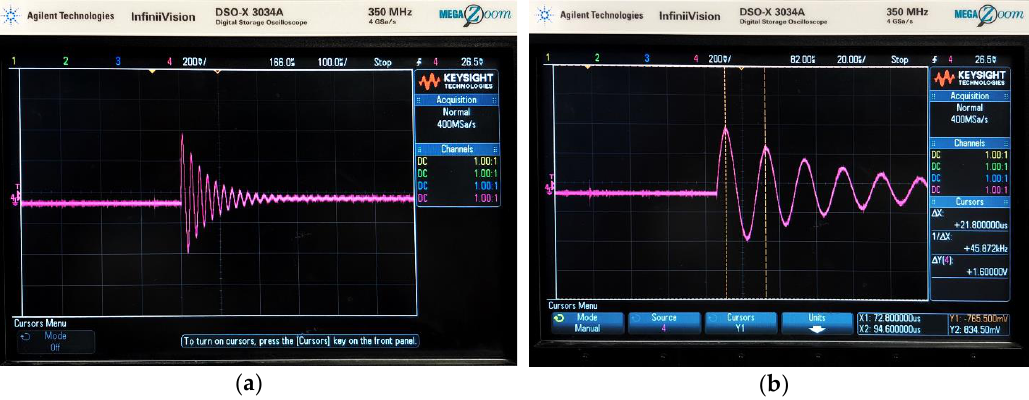
Figure 2. ( a ) Oscilloscope output for an undamped transient response of an RLC circuit where L = 64.3 μH and C = 0.2 μF with time on the x-axis and charge across the capacitor along the y-axis. ( b ) The cursors represent time period for the oscillation with the highest amplitude, the inverse of which gives us the resonance frequency.